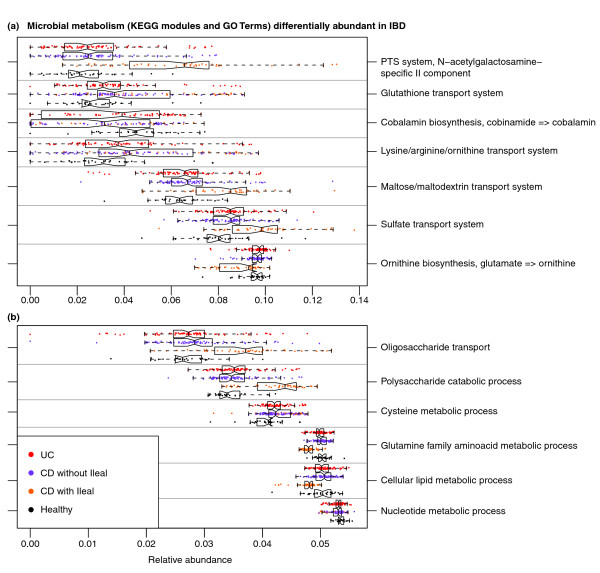
Small metabolic modules and biological processes with significantly altered abundances in the IBD microbiome. (a, b) Small (typically 5 to 20 gene) KEGG modules (a) and independently defined biological processes from the Gene Ontology (b) were assessed for significant association with disease and ileal involvement as in Figure 4. Metabolism related to oxidative stress (for example, glutathione and sulfate transport) and for pathobiont-like auxotrophy (for example, N-acetylgalactosamine and amino acid uptake) is increased, while several basic biosynthetic processes are less abundant.